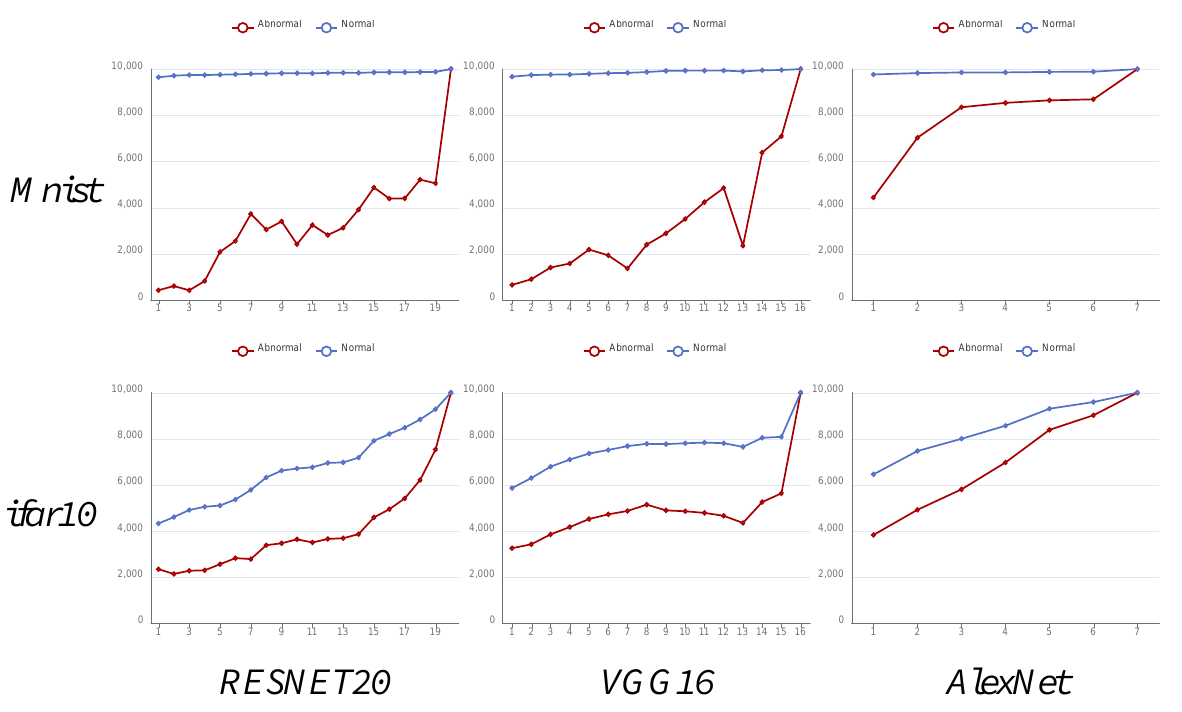
Figure 4. Pre-experiment results. X-axes and Y-axes indicate sub-model indexes and the numbers of sub-models with the same classification results as the original